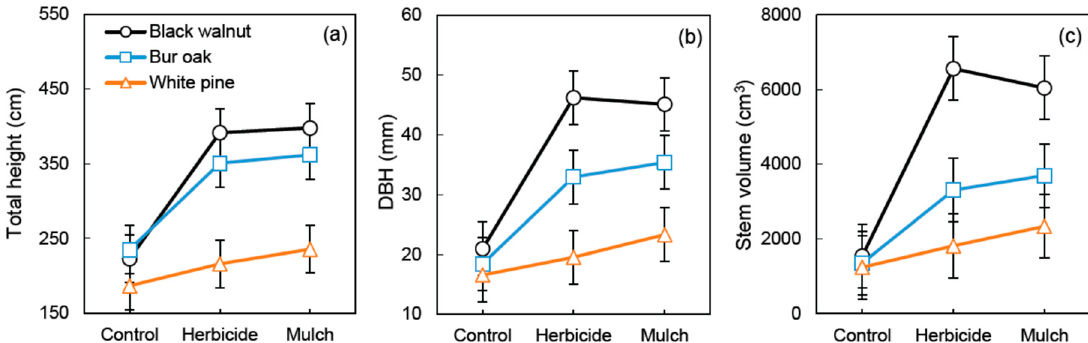
Figure 4. Stem volume per tree measured after 2, 3, 4, and 5 years of growth in an agricultural riparian buffer. The Species × Vegetation treatment × Time interaction is significant at p < 0.05 according to multivariate analysis of variance (MANOVA).